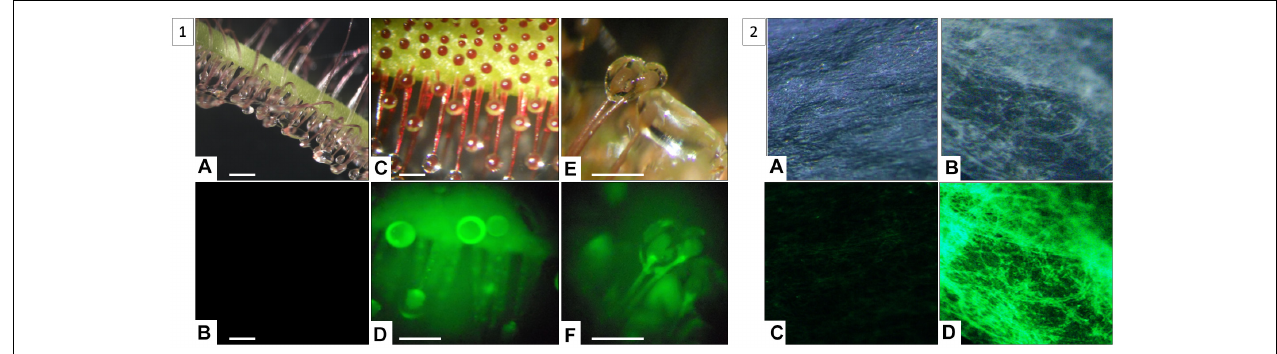
FIGURE 3 | Highlighting of GFP secreted by tentacles (1) outside plant tissues into secretions of gfp -transformed D. capensis (2). (1) Observation of D. capensis wild-type tentacles (A,B) (scale = 1 mm) and gfp -transformant tentacles (C–F) (scale = 0.5 mm) under natural light (A,C,E) and under UV-light (B,D,F) ; (2) Observation of glue absorbed directly on Whatman paper from wild-type plant (A,B) and gfp -transformant (C,D) and under exposition to natural light (A,C) and UV-light (B,D).